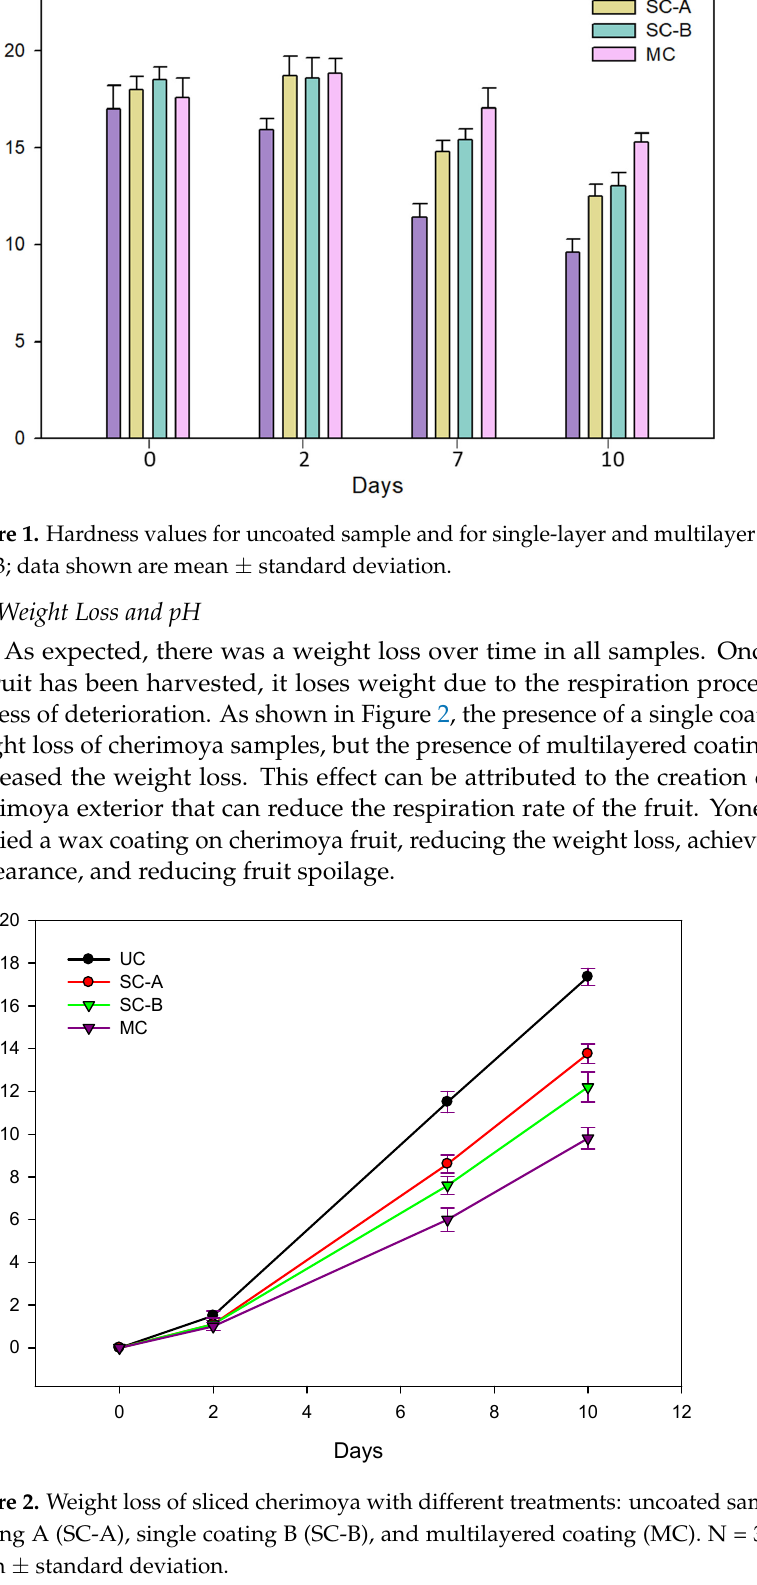
Figure 3. pH values of sliced cherimoya with different treatments: uncoated samples (UC), single coating A (SC-A), single coating B (SC-B), and multilayered coating (MC). N = 3; data shown are mean ± standard deviation. 3.3. Total Phenolic Content Edible coatings can act as a barrier to prevent the gas transfer and protect the fruits against the oxidation process. Phenolics have a chemoprotective effect and can positively